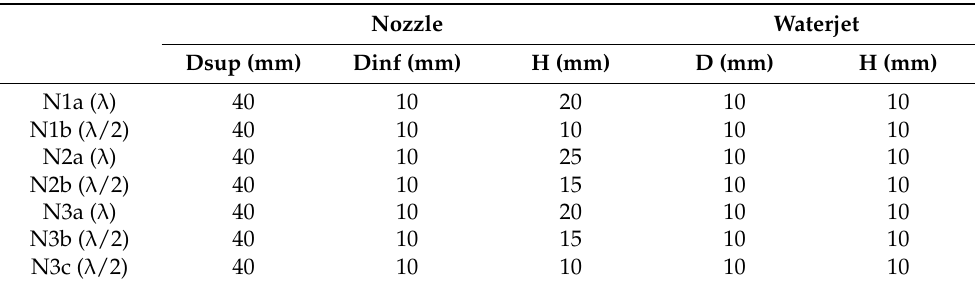
Figure 4. Received A-scans in studied geometries.